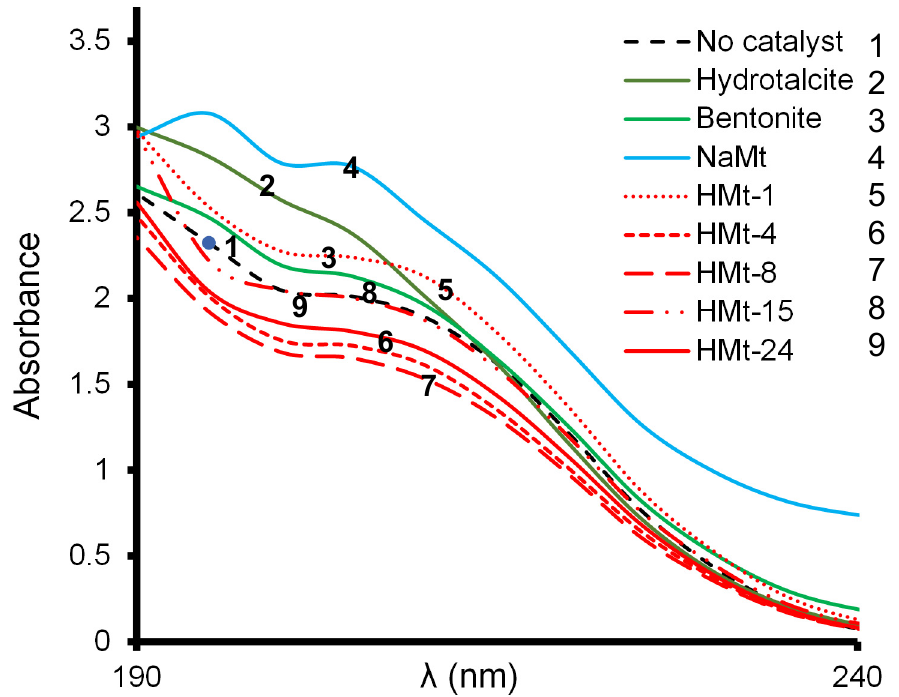
Figure 1. UV-Vis spectra close-ups of clay-free LA solution (dashed line of curve 1) and of the supernatant of the different clay suspensions in the 190–220 nm region. These spectra were recorded at T = 20 ◦ C and intrinsic pH of the aqueous clay suspensions. Quartz cell = 1 cm. Initial concentration 2.5 g L − 1 (27.75 mM). Contact time: 20 min .